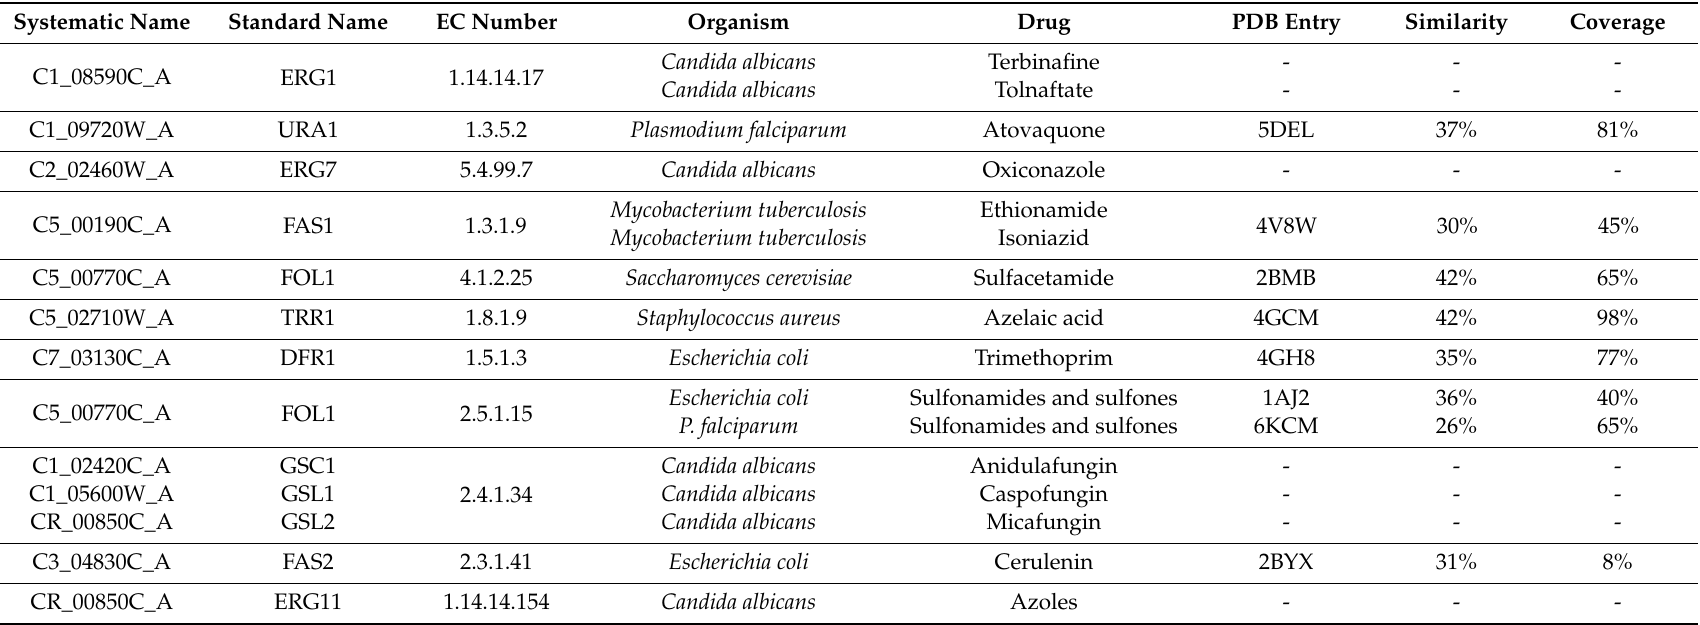
Table 6. Drug targets evaluated for gene essentiality prediction in RPMI medium, as identified by the iRV781. Data retrieved from DrugBank database; only drugs with known pharmacological action were